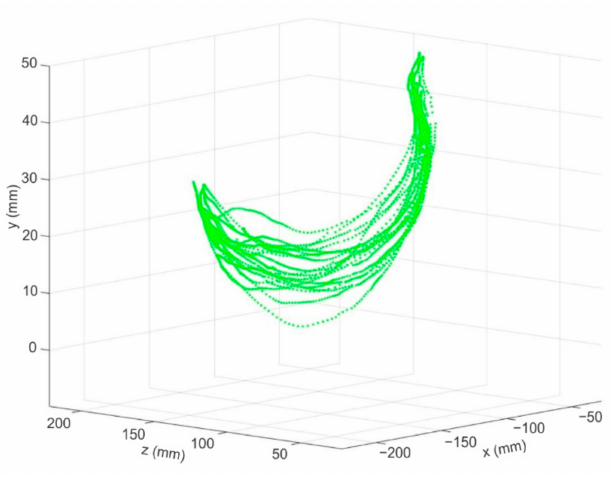
Figure 11. Flexion–extension movement in the space for the index finger of a